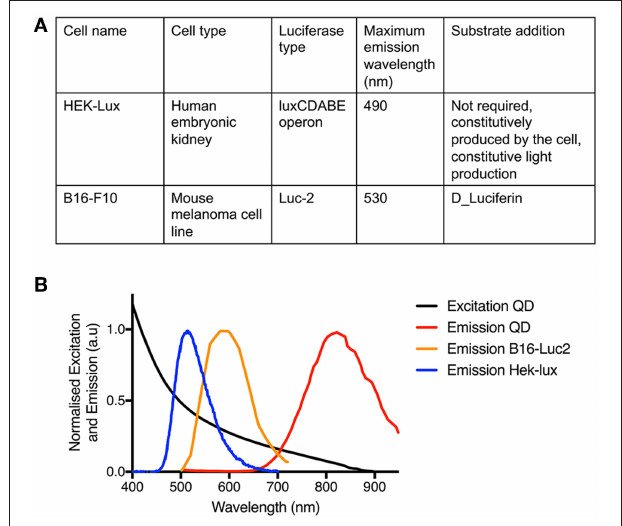
FIGURE 1 | Characteristics of the materials used. (A) Table presenting the features and properties of the two cell lines. (B) Normalized absorption spectrum of the NIR QDs and normalized emission spectra of the NIR QDs, the HEK-Lux cells, and the B16-Luc2 cells.